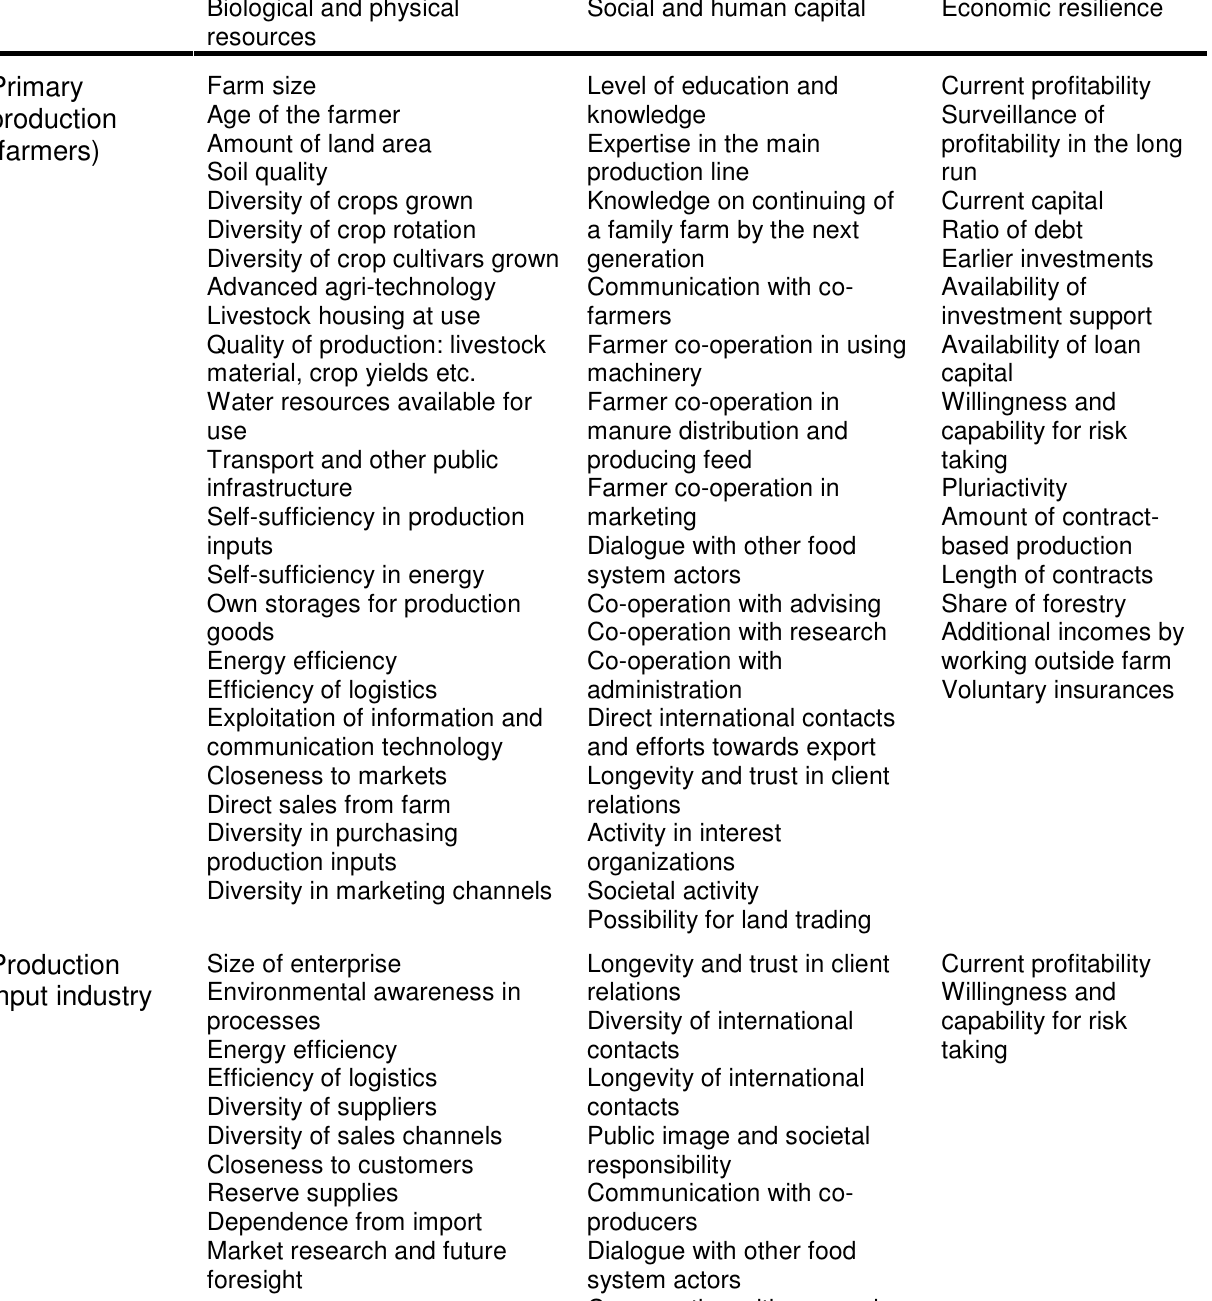
Table A1.1. Suggestions from the brainstorming session of the determinants of adaptive capacity in terms of actors and for the food system as a whole. Determinants are classified based on their predicted central role in strengthening biological and physical resources, social and human capital, or economic